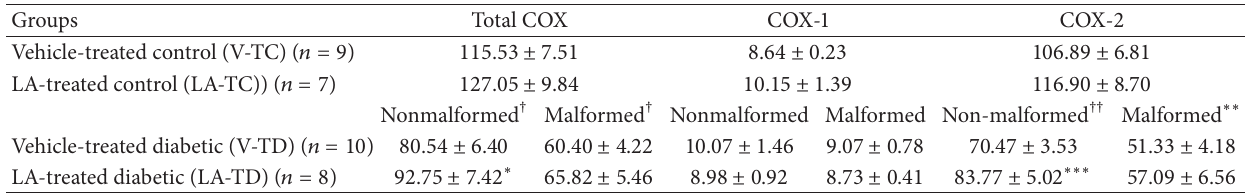
Table 7: COX activity membranes (U/mg of